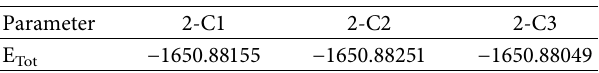
Figure 3: Binding modes of (a) the native ligand, desipramine, (b) standard drug, maprotiline, (c) compound 1, (d) compound 2 , (e) compound 5, and (f) compound 6 and at the central binding site of LeuT. Table 2: Energies (a.u.) of the predicted conformations of the compound 2